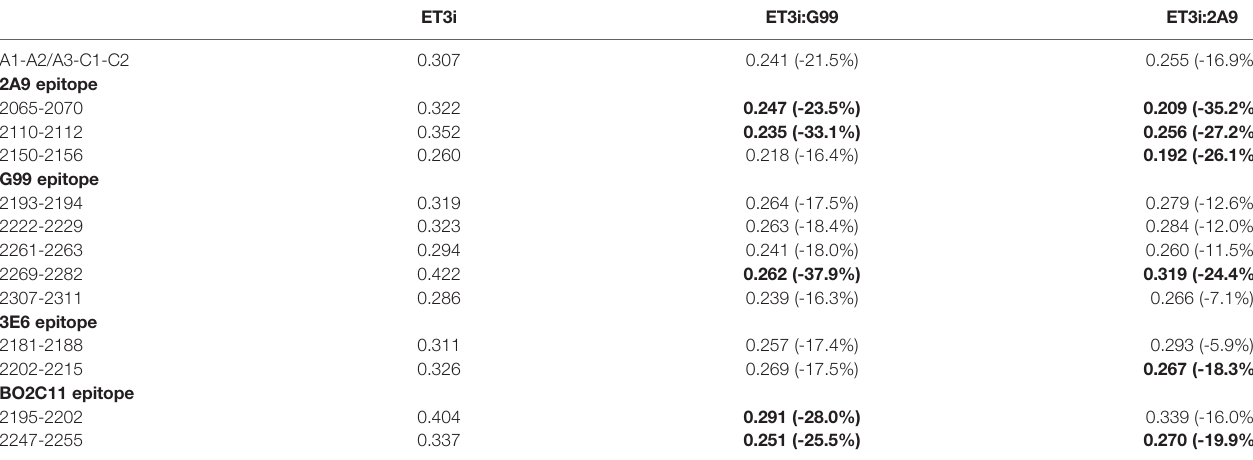
TABLE 1 | Average B ’ values for C1 and C2 domain